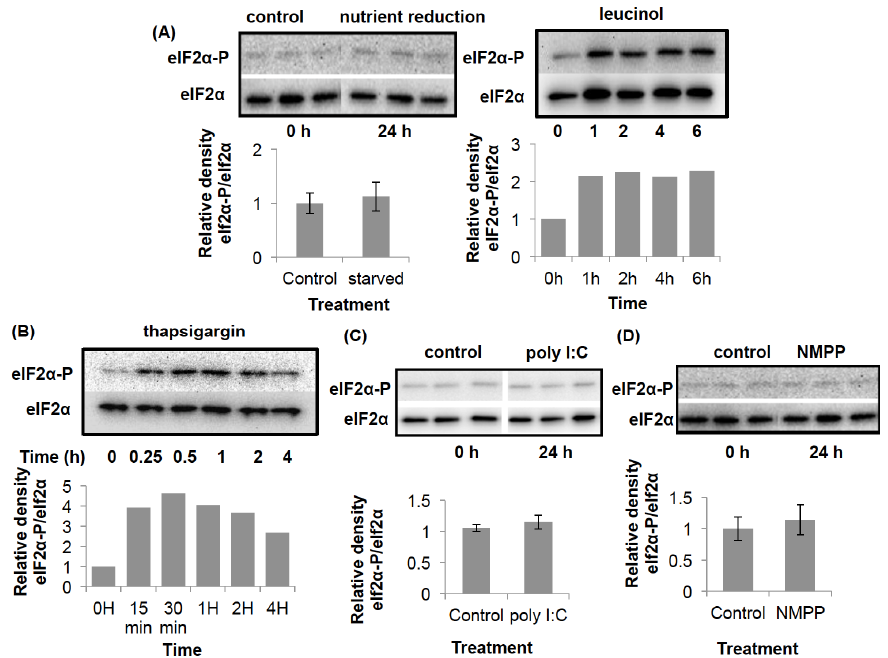
Figure 4. Response of cobia muscle cells to activators of eIF2-kinases Cobia muscle cells treated with known activators of eIF2 α -kinases: ( A ) nutrient reduction cells were maintained in 30% L-15 cell culture medium in PBS for 24 h; ( A ) leucinol (4 mM), for up to 24 h, for activation of GCN2; ( B ) thapsigargin (1 μ M), for up to 2 h, for activation of PERK; ( C ) poly I:C (50 μ g/mL), for 24 h, for activation of PKR; ( D ) NMPP (2 μ M), for up to 24 h, for activation of HRI. Proteins in cell extracts were fractionated by SDS-PAGE, and eIF2 α was visualized by chemiluminescence following electro-transfer to PVDF. The blots were probed first with antibodies to phosphorylated eIF2 α and, after stripping, antibodies to total eIF2 α . Chemiluminescence was detected and an image generated (upper panels) using the ProteinSimple Fluorochem E, with quantification using ImageJ. The bar diagrams in the lower panels represent the quantification of the blots corresponding to the respective lanes in the upper panels and reflect the relative density of eIF2 α to phosphorylated eIF2 α .